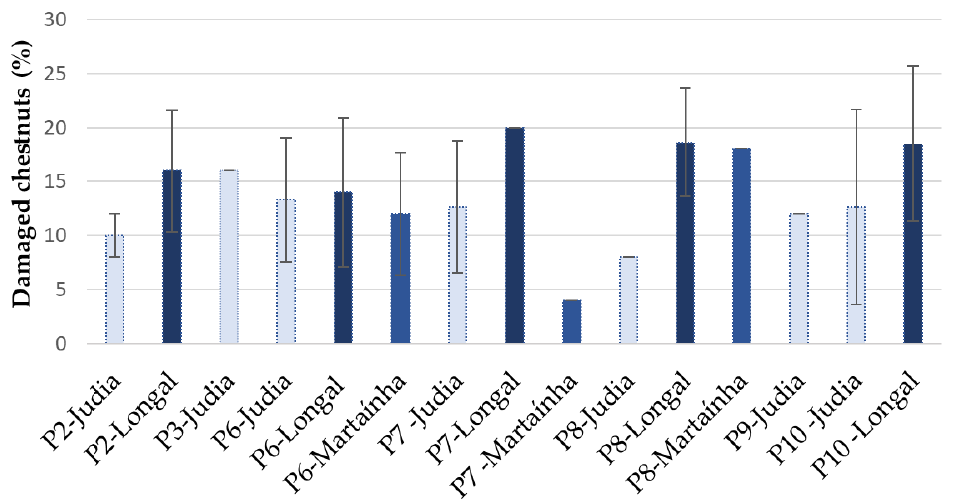
Figure 1. Percentage of external damaged chestnuts at different processing stages for the chestnut varieties Longal (dark blue), Judia light blue) and Marta í nha (intermediate blue) (mean ± SD; n = 50). P2, P3—sterilized chestnuts (0 and 15 days storage); P6—unsterilized chestnuts in reception; P7, P8, P9—unsterilized chestnuts after storage (15, 30 and 45 days, respectively); P10—sterilized chestnuts rejected by sorting.